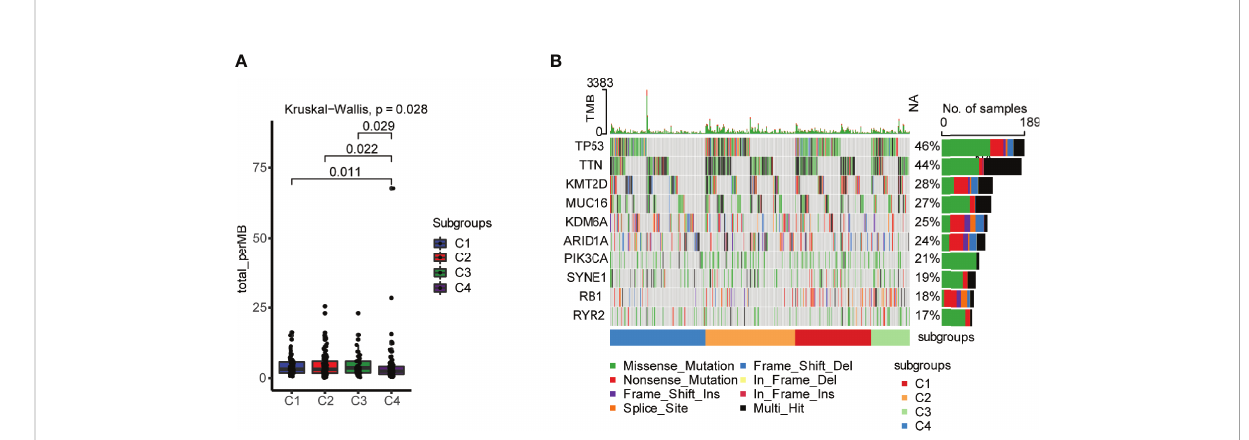
FIGURE 2 Landscape of tumor mutational burden (TMB) in four different immune subtypes. (A) TMB in four different immune subtypes of bladder urothelial carcinoma. (B) Mutation status of the top 10 immune genes with genomic alterations in the four different immune subtypes of bladder urothelial carcinoma.